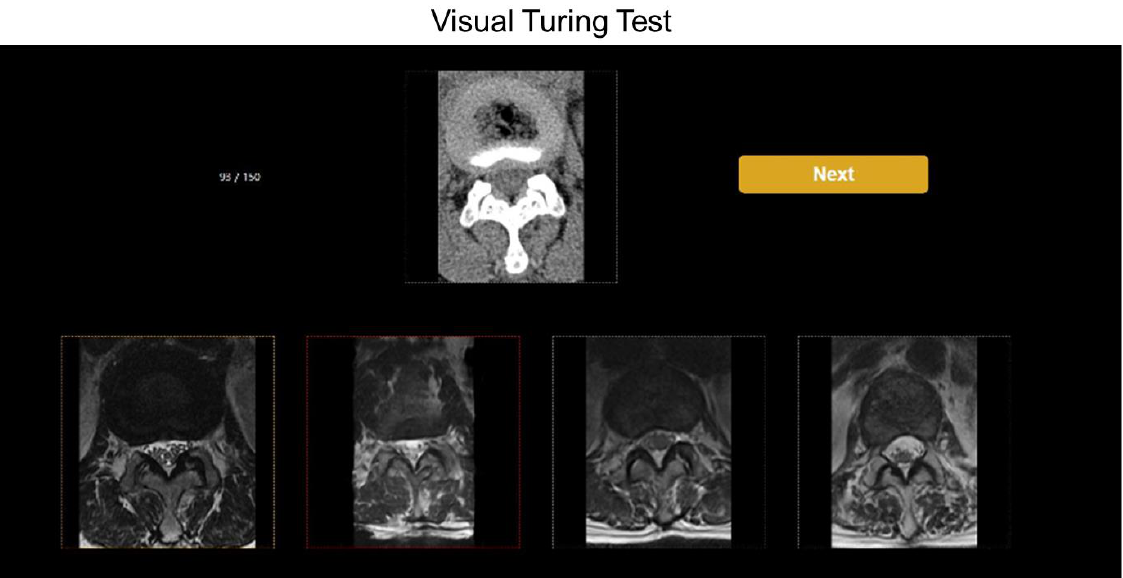
Figure 4. The validation set comprised 150 true and 450 synthetic images developed by 3 algorithms. The true and synthetic images were randomly mixed and displayed on the web solution. Four readers independently determined which MR image best reflected the axial CT image at the disc level and for real. The yellow and red frames of the MR images indicated the first and second choices, respectively. MR, magnetic resonance; CT, computed tomography.